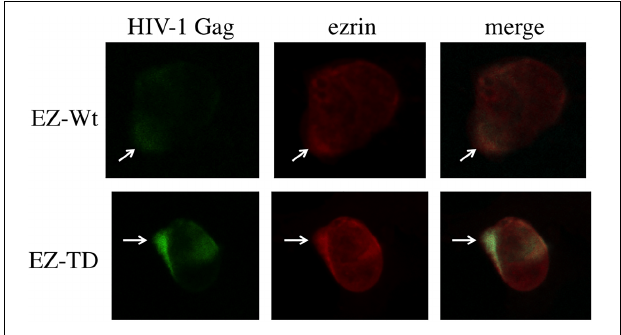
FIGURE 5 | Cellular localization of HIV-1 Gag and ezrin proteins. COS7 cells were transfected with the HIV-1 vector construction plasmids together with the EZ-Wt or EZ-TD expression plasmid, and permeabilized with methanol. The cells were first stained with mouse anti-VSV-G epitope and rabbit anti-HIV-1 p24 antibodies, and then with Cy3-conjugated anti-mouse IgG and FITC-conjugated anti-rabbit IgG antibodies. The cells were observed under a laser confocal microscope. Representative results are